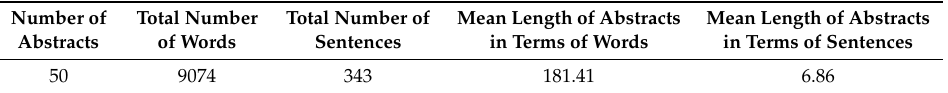
Table 1. Frequencies in the corpus for abstracts, words, sentences and their mean lengths.